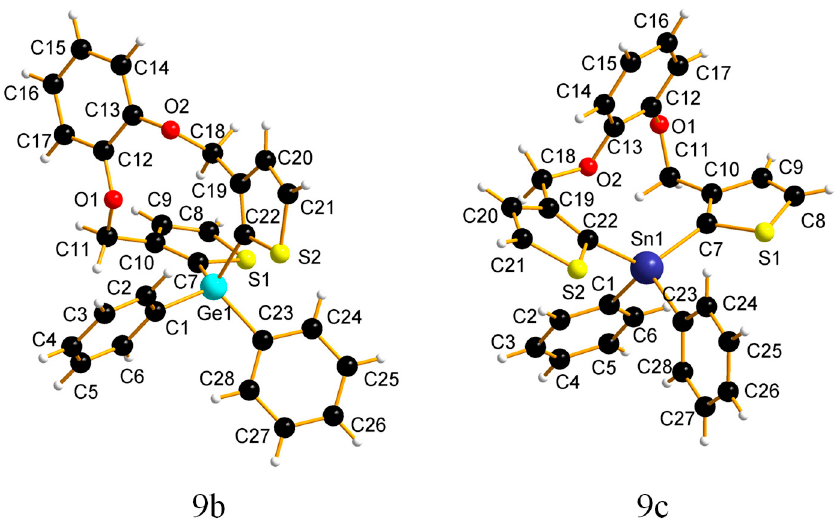
Figure 1. Molecular structures of compounds 9b and 9c , showing a 50% probability of ellipsoids.